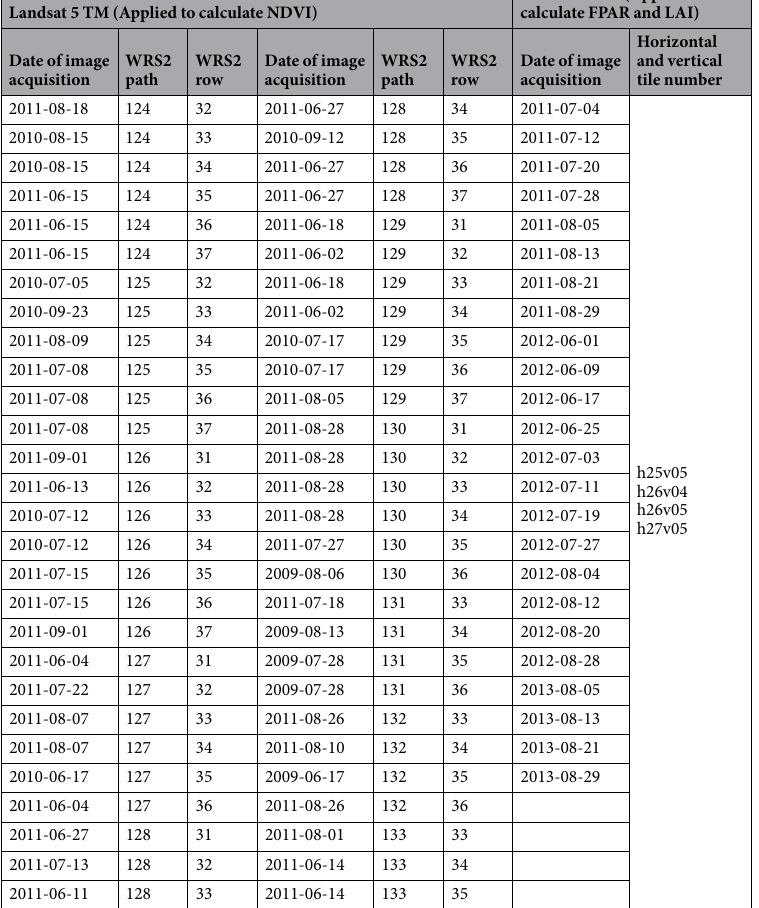
(3) MODIS-Terra, MOD15A2H FPAR and LAI data (Table 1) Moderate-resolution imaging spectroradiom- eter (MODIS) data (MOD15A2H version 6, MODIS Level 4) were acquired during the morning from the MODIS-Terra satellite. We downloaded eight-day composite products (500-m resolution) for 2011, 2012 and 2013 from the National Aeronautics and Space Administration (NASA) website (http://www.nasa.gov/). The downloaded data were used to extract the FPAR and LAI products using the MODIS Reprojection Tool (MRT). (4) Topographic data Digital elevation modelling (DEM) data with a 30-m horizontal spatial resolution from the ASTER GDEM version 2.0 product covering the Loess Plateau were downloaded from the USGS web- site (http://earthexplorer.usgs.gov/). We processed the data using the ArcGIS10.0 toolbox (Environmental Systems Research Institute, Inc., ESRI) to determine the slope of the Loess Plateau. (5) Climate data Quality-controlled climate data collected during 2011~2013 from 64 meteorological stations on the Loess Plateau were available from the National Climate Centre of the China Meteorological Admin- istration (http://www.nmic.gov.cn). The data included the average monthly temperature, average monthly precipitation, and annual maximum and annual minimum temperature. The meteorological station point data were interpolated to fitted surfaces (100-m pixel cells) over the Loess Plateau using the ANUSPILN package, which contains FORTRAN programmes to fit the surfaces of one or more independent vari- ables 50 . The average summer temperature and average summer precipitation were calculated using the monthly average temperature and precipitation values for June, July and August. (6) Auxiliary data A total of 24,094,252 control points were generated in the grassland to set the spatial resolu- tion of the predicted AGB map to 100 m. The longitude and latitude of the control points were considered auxiliary data in this study, and the geographic projections of all maps were WGS 1984.